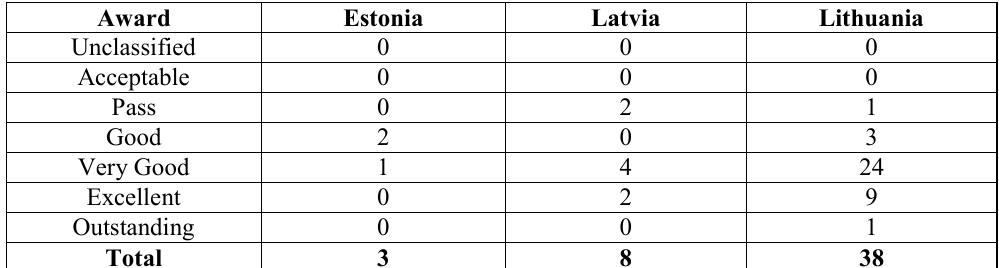
Table 5. BREEAM Projects (Developed by